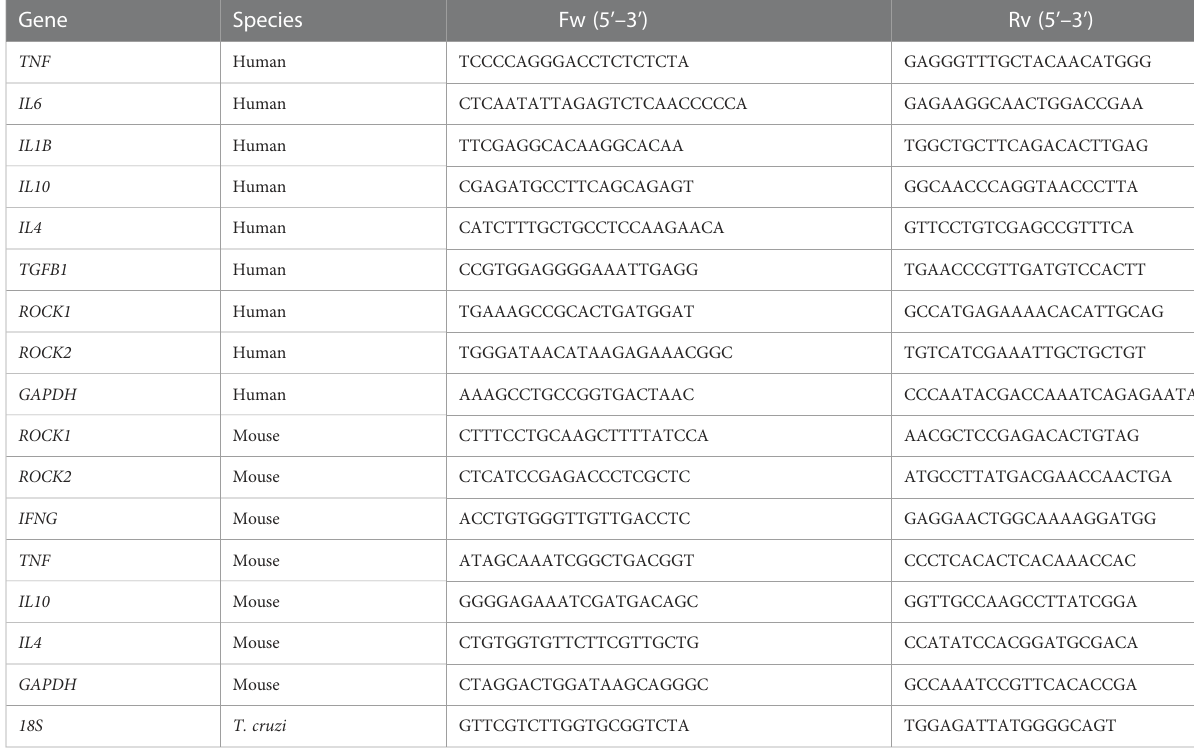
TABLE 1 Sequences of primers used for the RT-qPCR determinations.